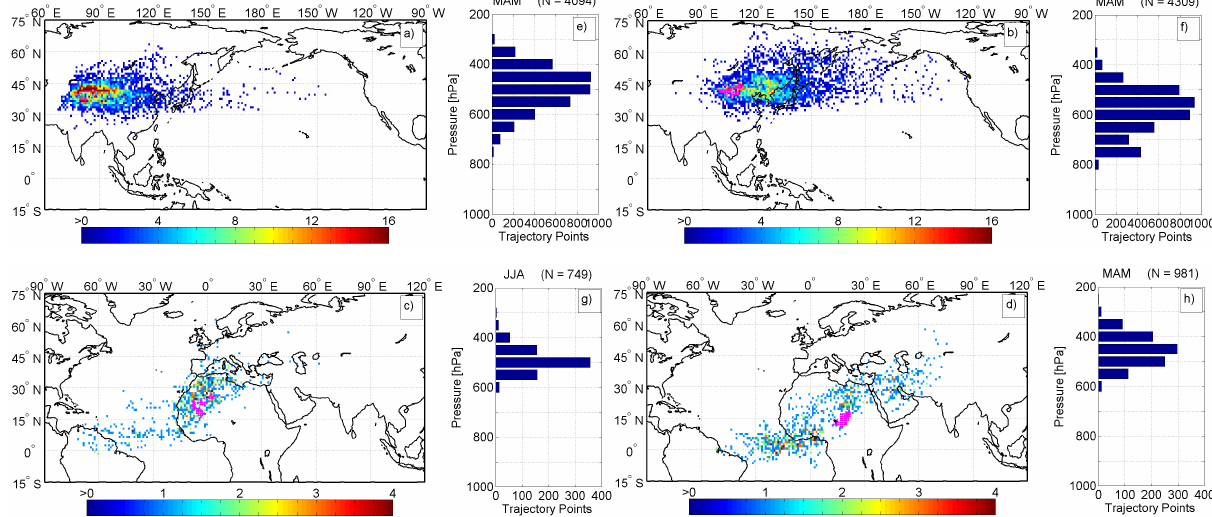
Fig. 10. Same as Fig. 9, except for WARM HET trajectory